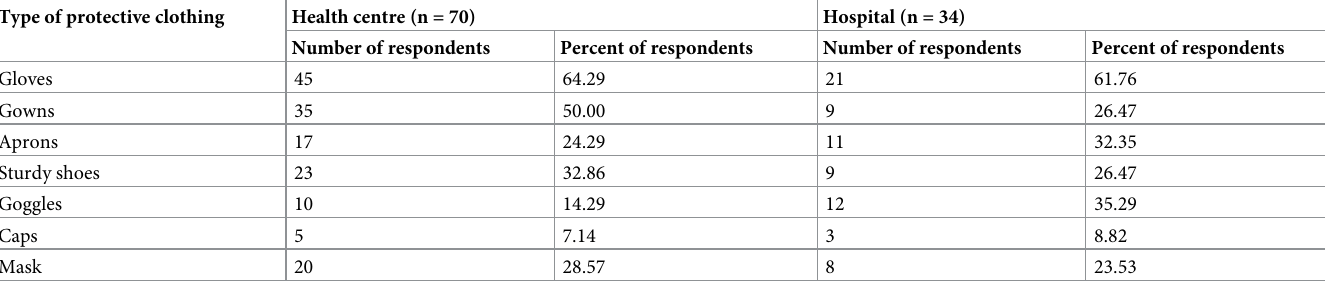
Table 8. Managers response to protective clothing used in the study health facilities, Addis Ababa City Administration, February 2018.